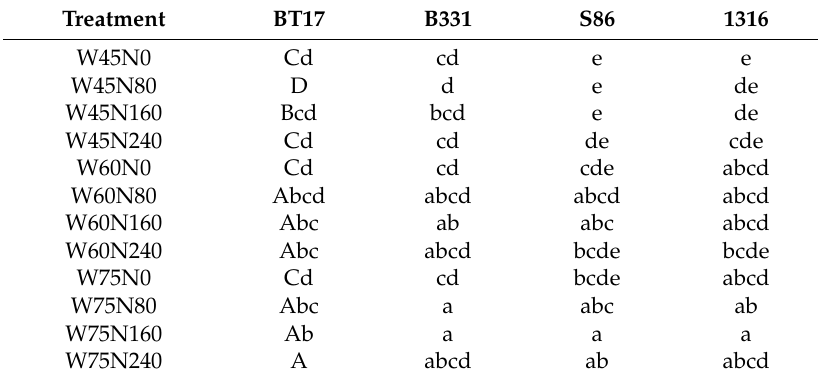
Table 4. Tukey’s honestly significant difference (HSD) test results of the means of stand volume increments under different water and nitrogen treatments for each clone. Treatment BT17 B331 S86